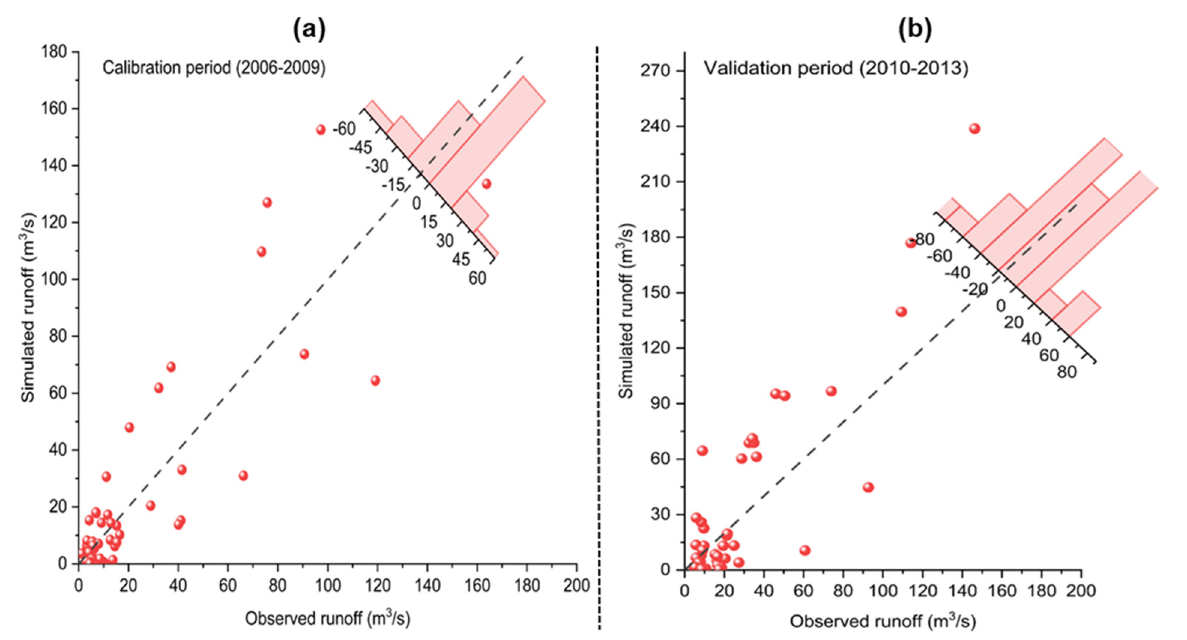
Figure 9. Simulated vs observed runoff for ( a ) calibration (2006–2009) and ( b ) validation (2010–2013) periods on monthly basis. The histogram shows difference of simulated and observed runoff values. Table 2. Model parameters used for calibration and